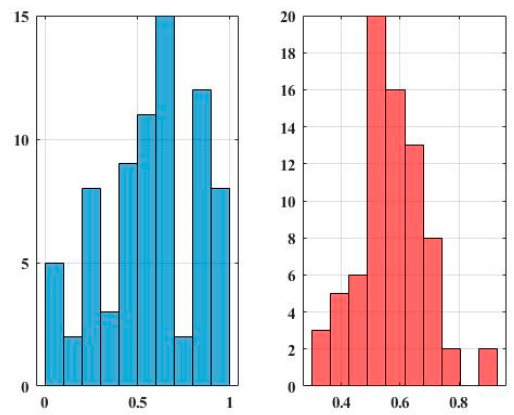
Figure 8. Histograms of the chunk scores of Mishakat al-Anwar , found for the averaged profile (the left panel) and its smoothed version (the right panel).